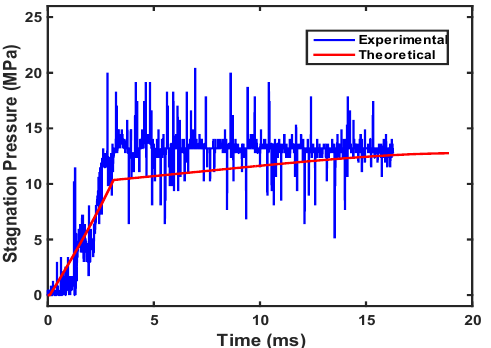
Figure 8. Experimental and theoretical overlay of stagnation pressure for initial velocity profile.